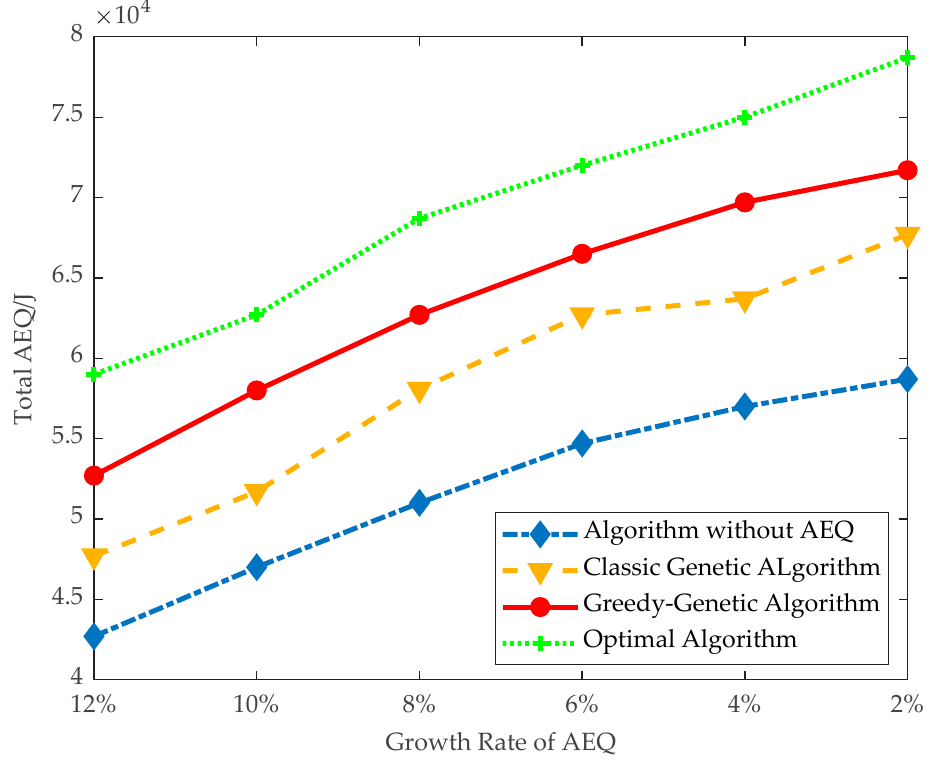
Figure 8. Total AEQ of small data instances.